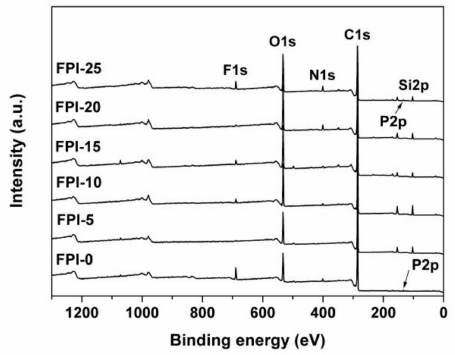
Figure 6. XPS spectra of PI films.